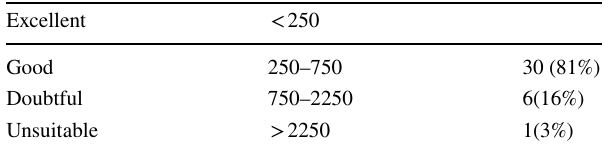
Table 2 Classification of electrical